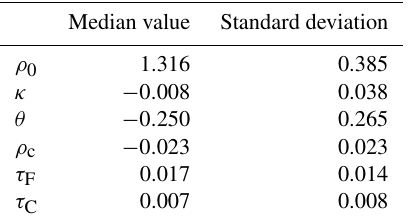
Table 8. Median and standard deviation of the scaled Jacobians. The table refers to all processed targets during 2015. The values are shown for the SEVIRI and PROBA-V bands centred at